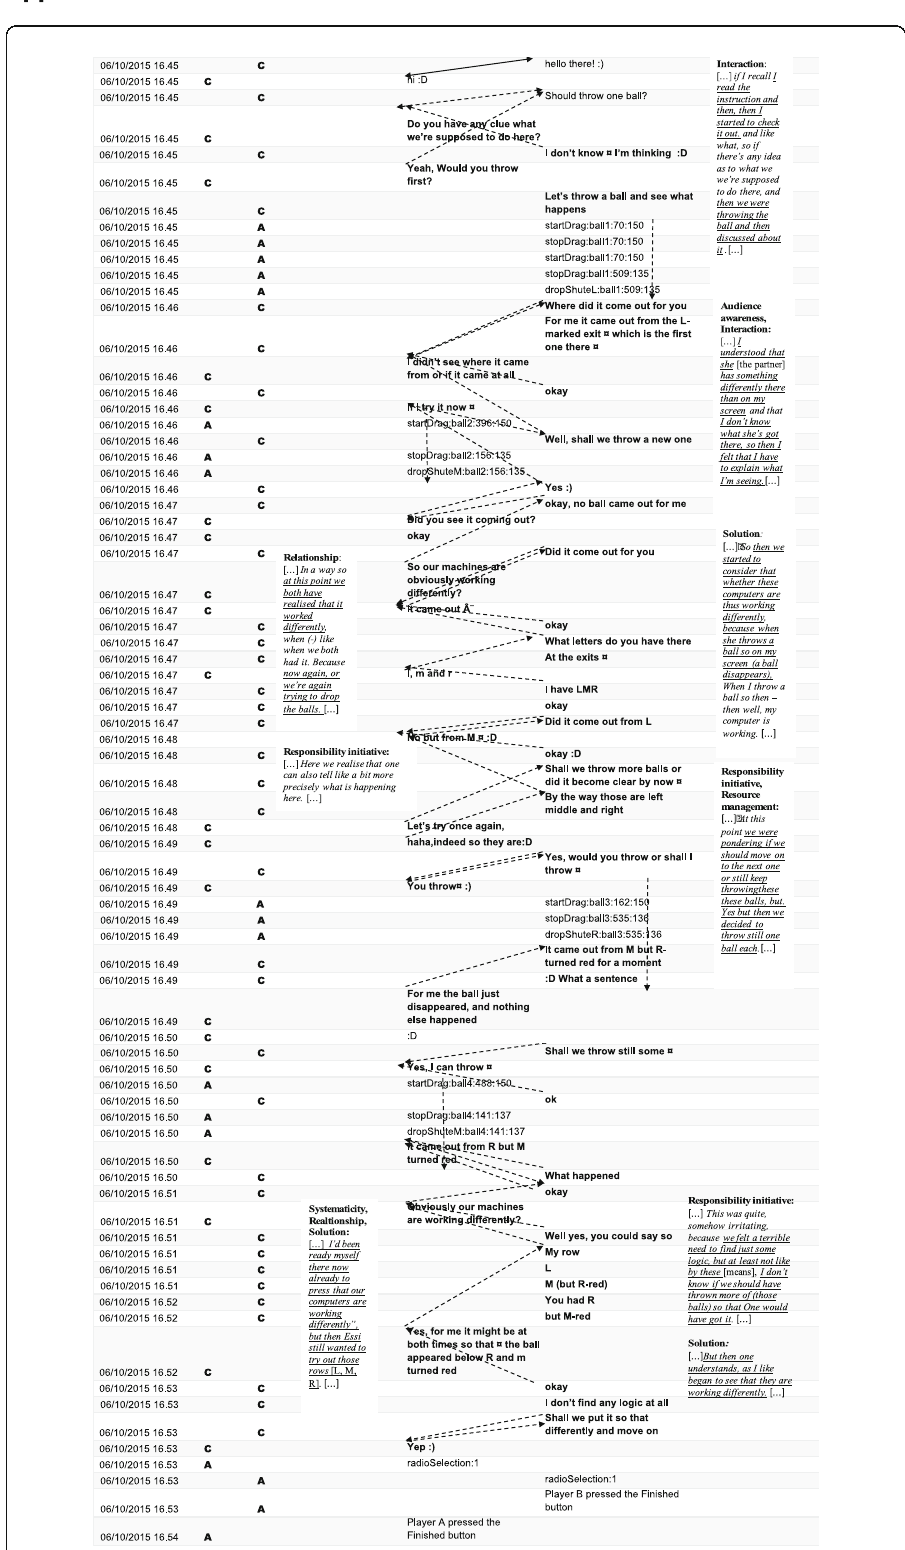
Fig. 10 The full episode of pair 24 (joint solution endeavour) in the Laughing Clowns